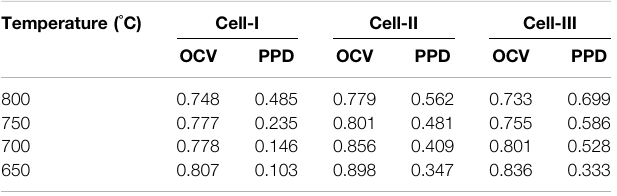
for long-term operation of cathode oxides will be con fi rmed in the follow-up long-term stability test.